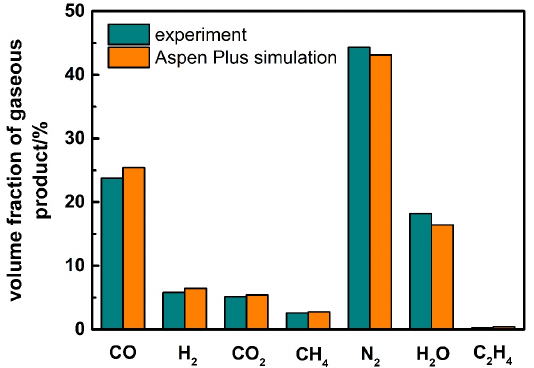
Figure 4. The comparison of gaseous product between experiment and Aspen Plus simulation results for the corn stalk. Because some carbon is discharged from the gasifier without complete oxidation re ‐ action due to insufficient reaction in the experiments, the gasification efficiency and the syngas yield of the simulation are more than that of experiments. The results of other types of biomass are similar to that of the corn stalk, so we do not show the results respec ‐ tively here. In general, although there is a deviation between the simulation and experiment results, the deviation is less than 10%, which can be ignored. The simulation results are in good agreement with the experiment, which verifies the Aspen Plus model. We can use this model to simulate and optimize the improved updraft biomass gasifier later.